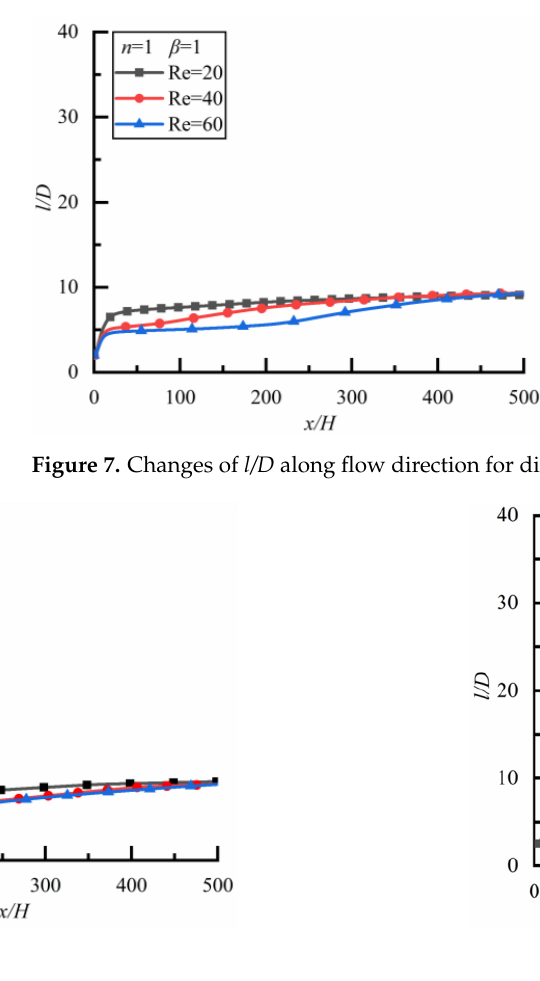
Figure 8. Changes of l/D along flow direction for different Re . ( a ) n =0.8, ( b ) n =1.2.